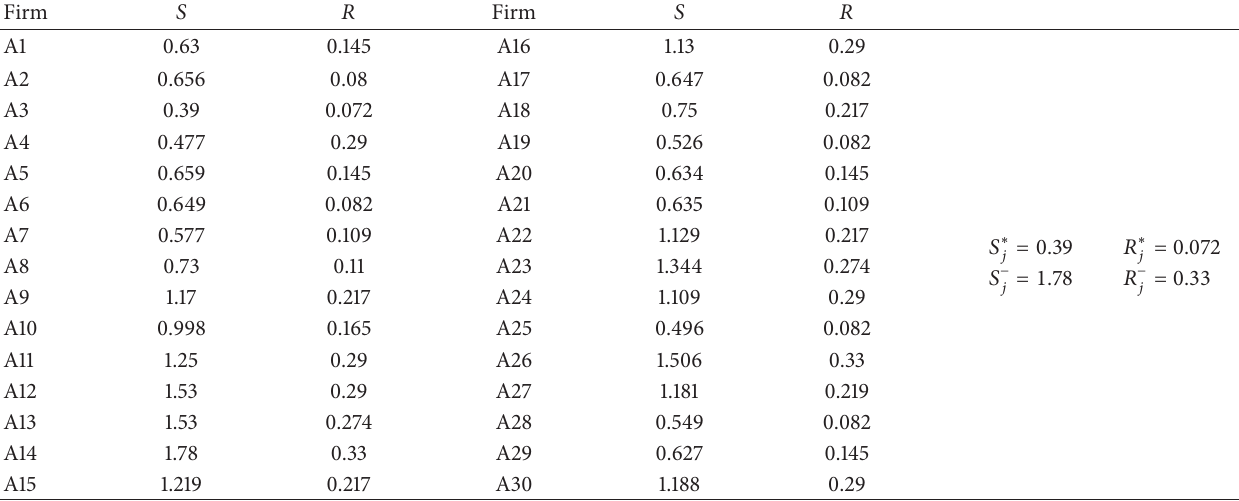
Table 8: The values of 𝑆 and 𝑅 for all